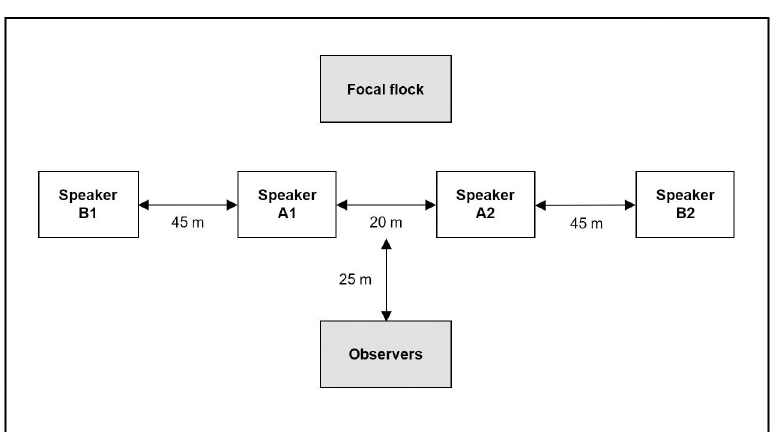
Fig 1. Schematic overview of the experimental speaker setup. Note that the schematic overview is not drawn to scale.